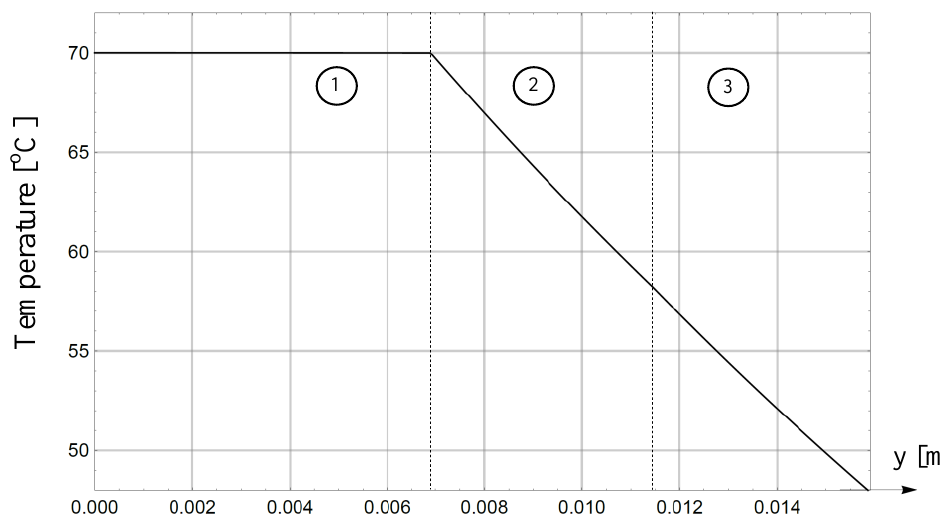
Figure 3. Temperature change in the elliptical conductor on semi-axis x = 0 (for I cr = 553.51 A ).